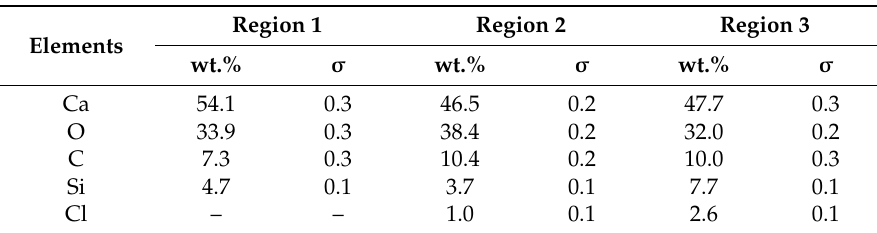
Figure 15. Microstructure characterizations of R0, G2, and G4 after leaching for 14 days: ( a ) the degraded zone of R0; ( b ) the intact zone of R0; ( c ) the degraded zone of G2; ( d ) the intact zone of G2; ( e ) the degraded zone of G4; and ( f ) the intact zone of G4. Table 8. The EDS data for the specified regions in Figure 15: (a) region 1 in Figure 15(b); (b) region 2 in Figure 15(d); and (c) region 3 in Figure 15(f).